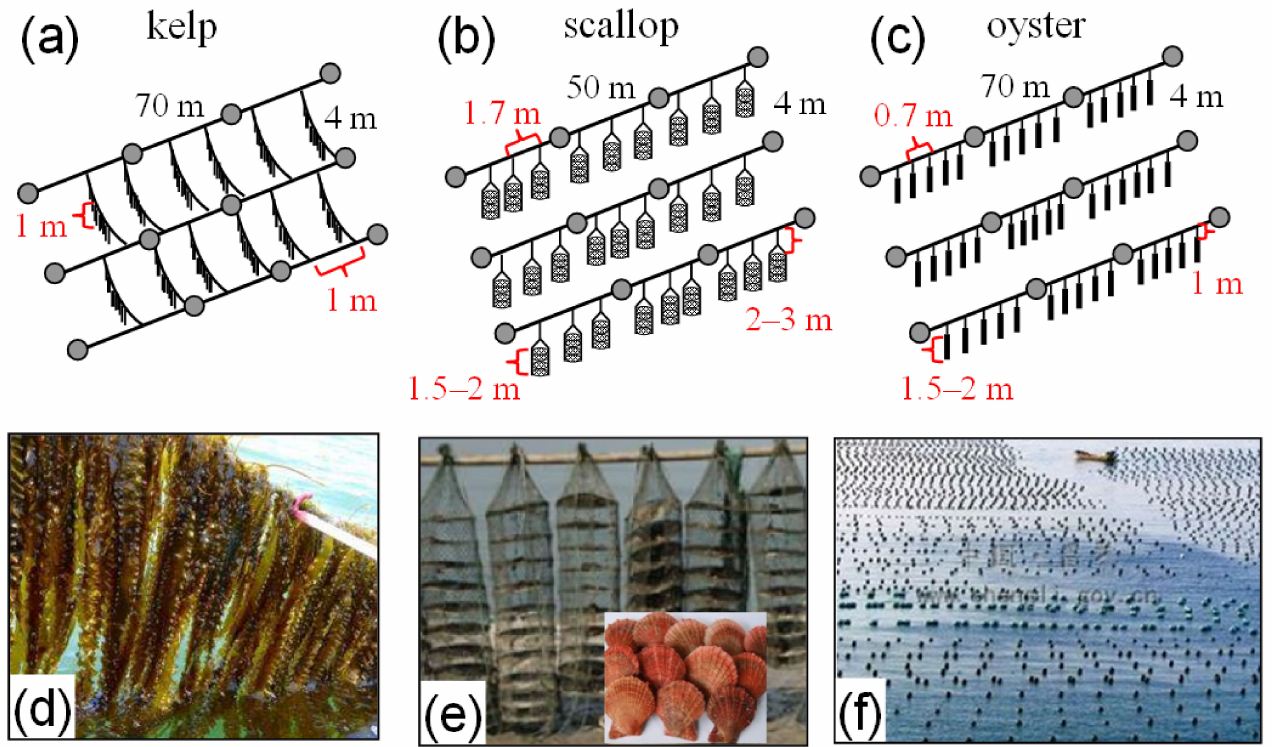
Figure 3. Culture methods for ( a ) kelps, ( b ) scallops, and ( c ) oysters; pictures for cultures of ( d ) kelps, ( e ) scallops, and ( f )